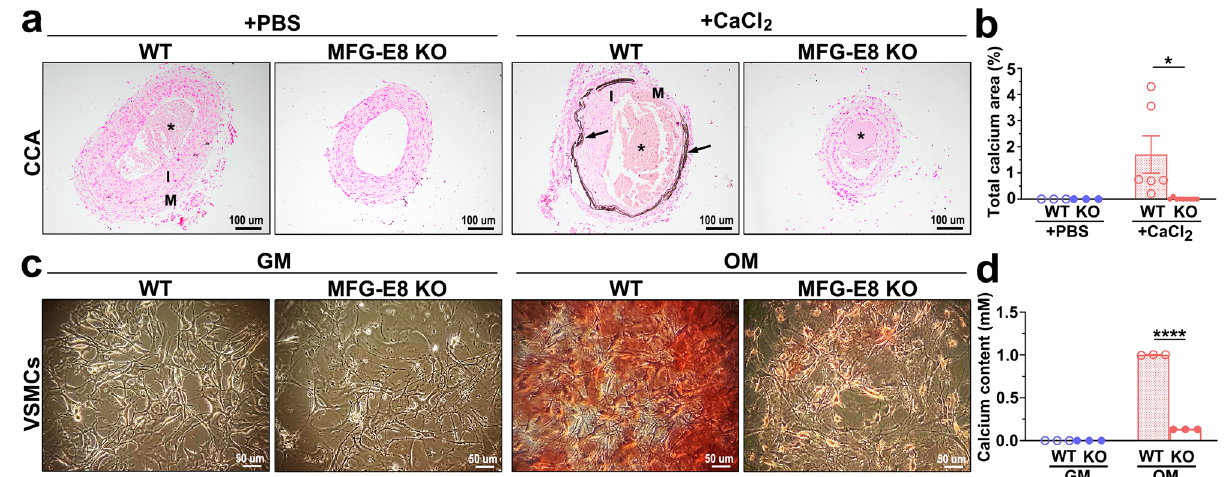
Fig. 2 Milk fat globule – epidermal growth factor 8 (MFG-E8) de fi ciency attenuates calcium deposition in calcifying vessels and vascular smooth muscle cells (VSMCs). a , b Ligated common carotid arteries (CCAs) of wild-type (WT) and MFG-E8-knockout (KO) mice were treated with pluronic gel containing 0.4 M CaCl 2 to induce vascular calci fi cation. a Representative images of von Kossa stain on CCAs sections from four groups of mice 21 days postligation. Arrows indicate calcium deposit in the vascular walls. The neointima (I), media (M), and blood clots (*) are indicated. Scale bar: 100 μ m. b Quanti fi cation of calci fi ed area in the arterial walls (WT + phosphate-buffered saline (PBS): n mice = 3, KO + PBS: n mice = 3, WT + CaCl 2 : n mice = 6, KO + CaCl 2 : n mice = 9). Results are presented as mean ± standard error of the mean. Each data point is derived from an assessment of three sections of one individual animal. * P < 0.05, obtained using one-way analysis of variance (ANOVA) followed by Tukey ’ s multiple comparison test. c , d VSMCs derived from the aortas of WT and MFG-E8-KO mice were cultured in growth medium (GM) and osteogenic medium (OM) for 7 days. c Representative microscopy images of alizarin red stain (ARS) of 7-day cultured VSMCs. Scale bar: 50 μ m. d Quantitative analysis of ARS contents in VSMCs ( n = 3). Data are presented as mean ± standard deviation. Three independent experiments were performed, and each experiment was repeated with similar results. The data were derived from one of the representative experiments. **** P < 0.0001, as obtained using one-way ANOVA followed by Tukey ’ s multiple comparisons